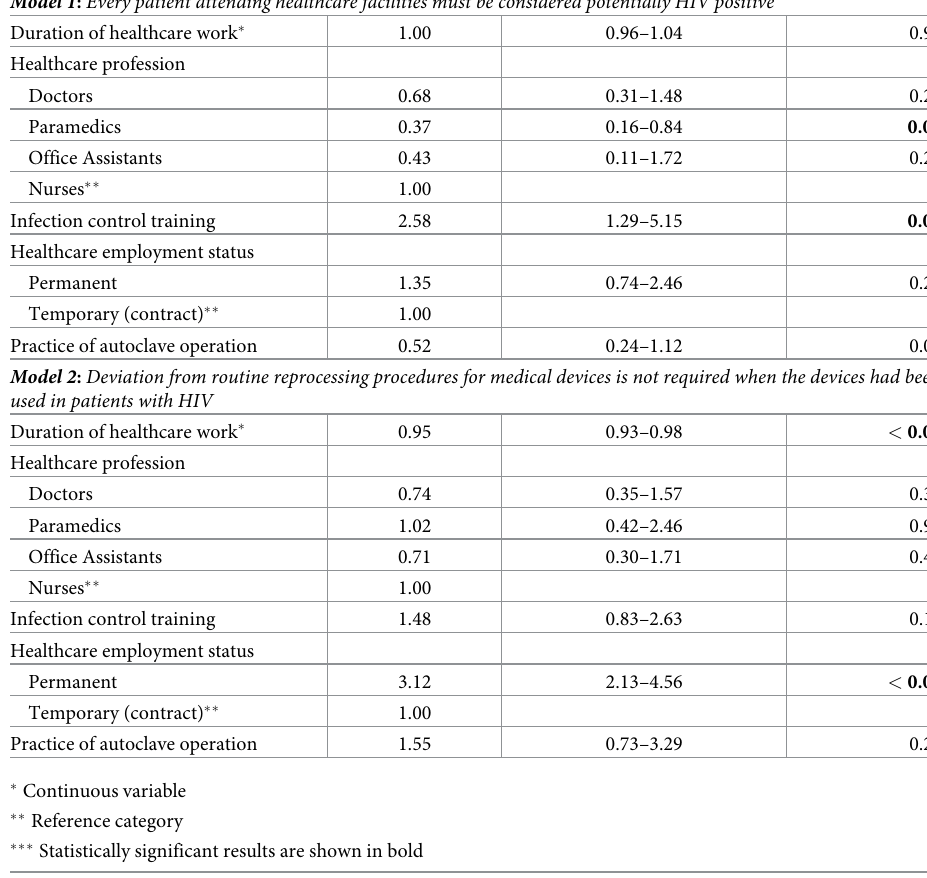
Table 12. Complex samples—ordinal regression models for the attitude of healthcare workers towards HIV and reprocessing of medical devices. Predictor Variable Odds Ratio 95% Confidence Interval Model 1 : Every patient attending healthcare facilities must be considered potentially HIV